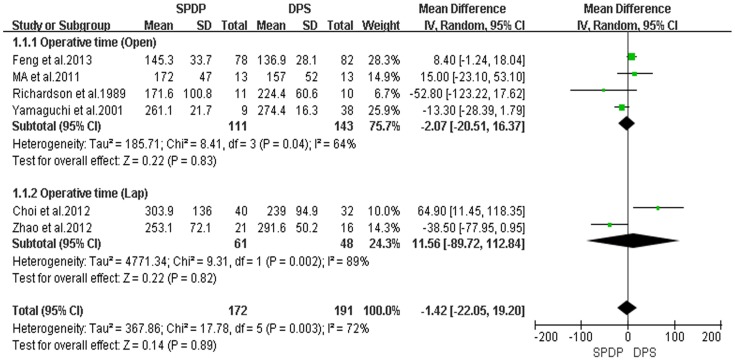
Operative time (min) (IV, Inverse variance, M-H, Mantel-Haenszel, CI, Confidence Interval; SD, Standard deviation).